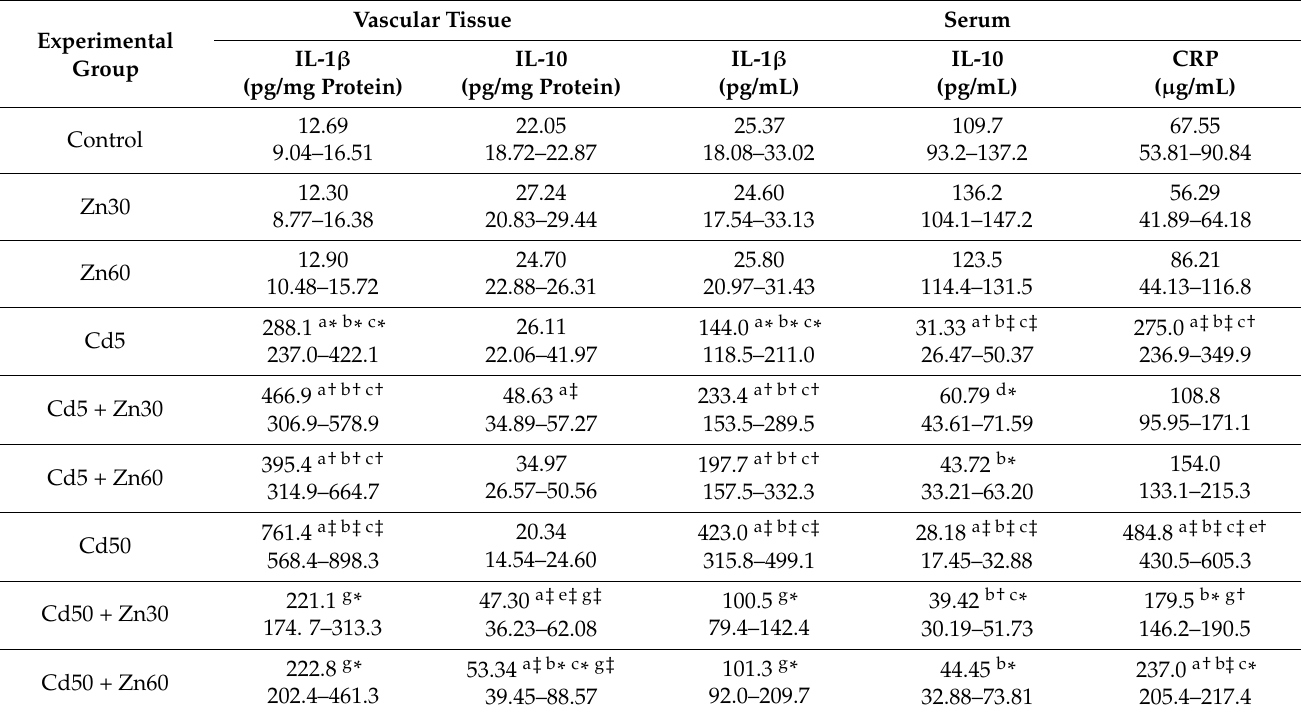
Table 4. The concentrations of biomarkers of inflammation in the vascular tissue of the abdominal aorta and serum in particular experimental groups 2